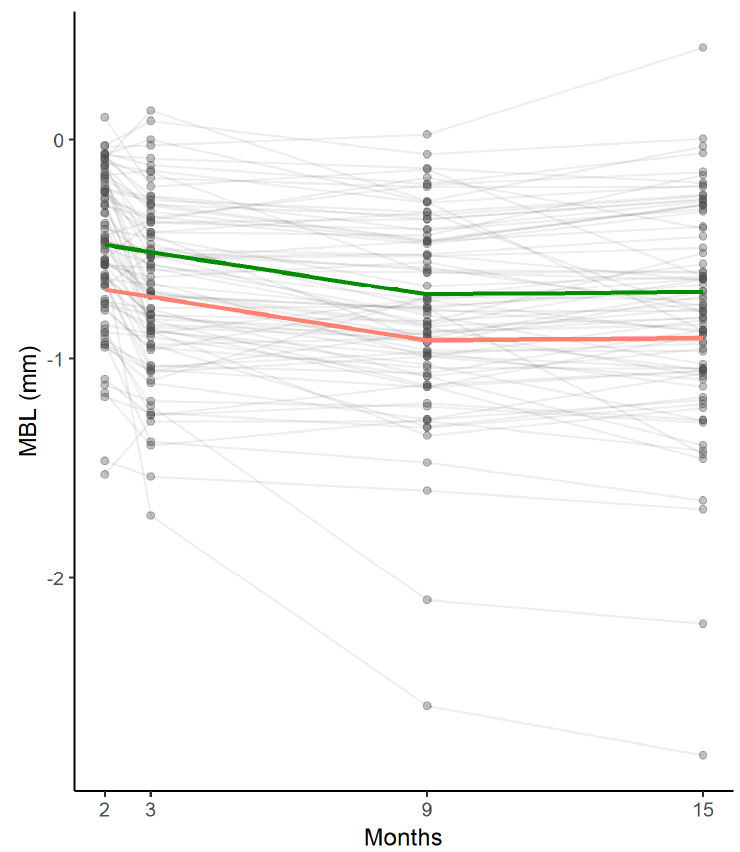
Figure 4. Marginal bone remodeling at different time points estimated by the statistical model: pattern of thick (green) and thin (pink) peri-implant mucosa in the entire sample. MBL: marginal bone loss.